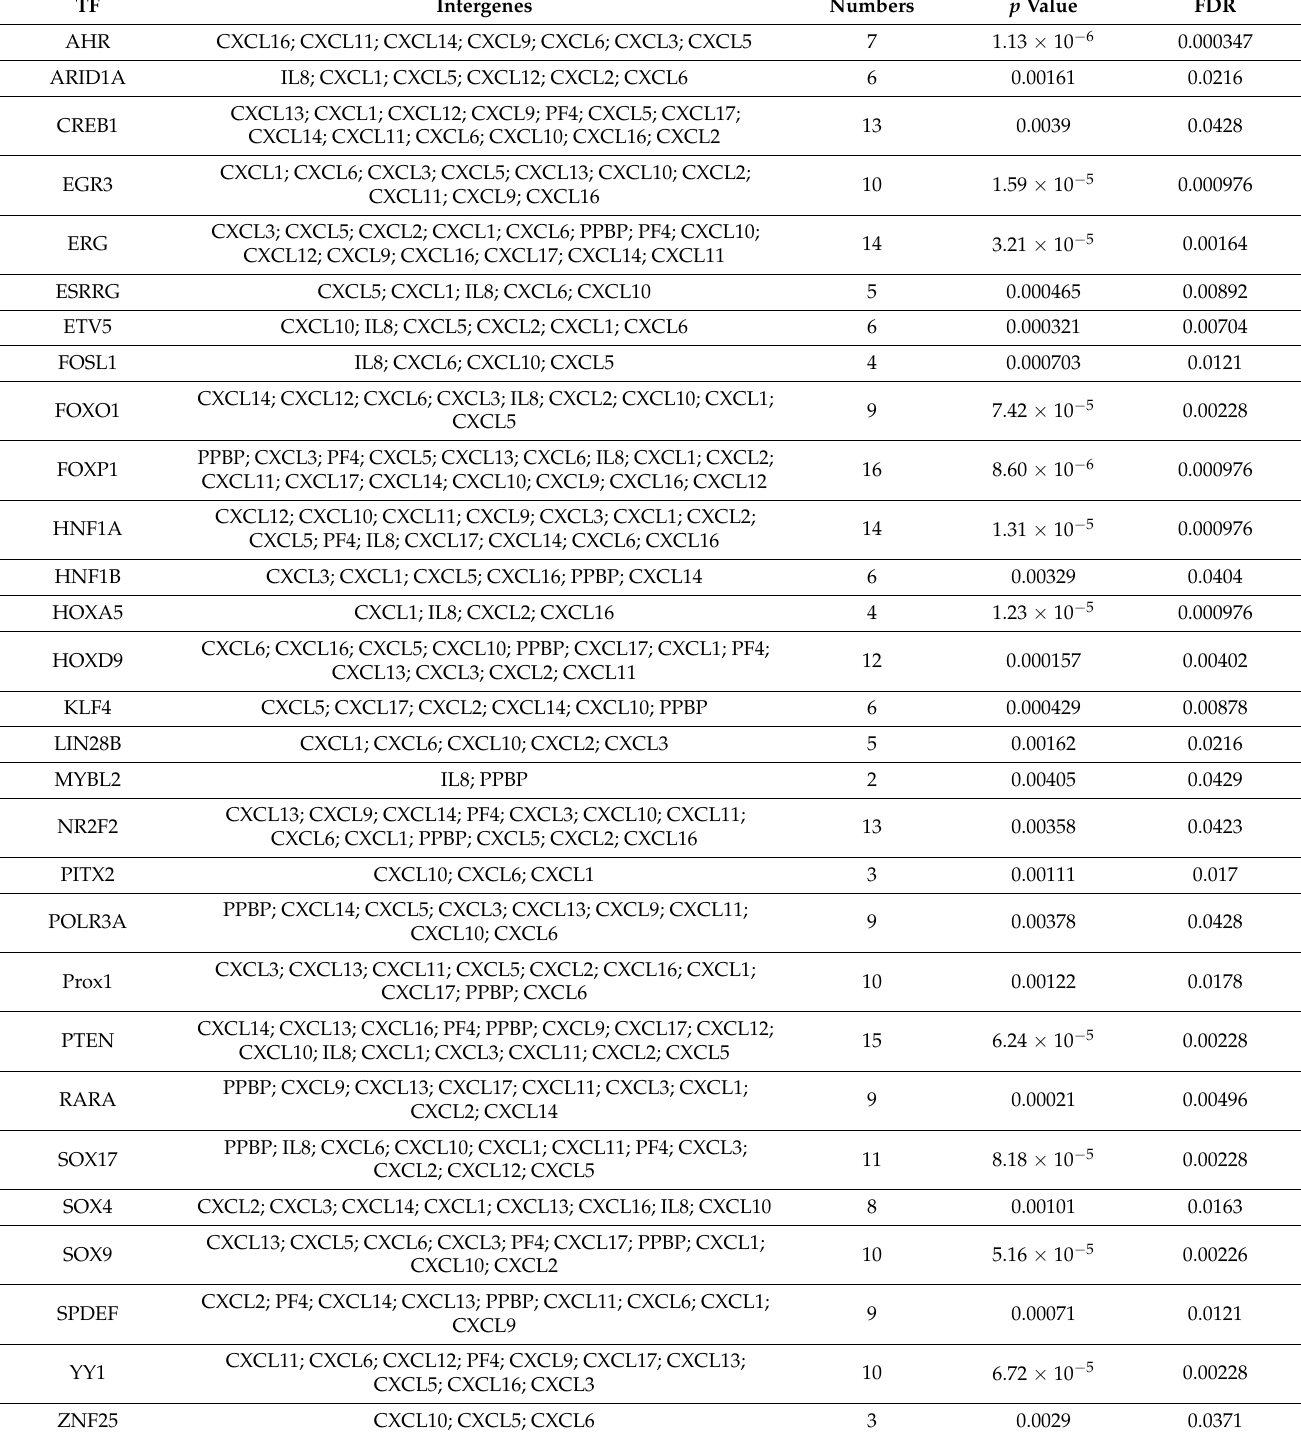
Table 4. TFs and corresponding intergenes searched in KnockTF